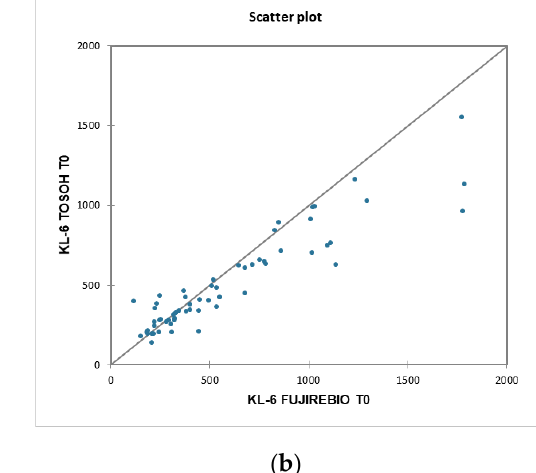
Figure 5. ( a ) Bland–Altman analysis using T0 KL-6 concentrations detected by two methods, CLEIA and FEIA by Lumipulse G600II and AIA360 system, respectively, for assessing agreement and Bias between systems. ( b ) Scatter plot analysis to perform linear correlation between KL-6 T0 Lumipulse G600II and AIA360.